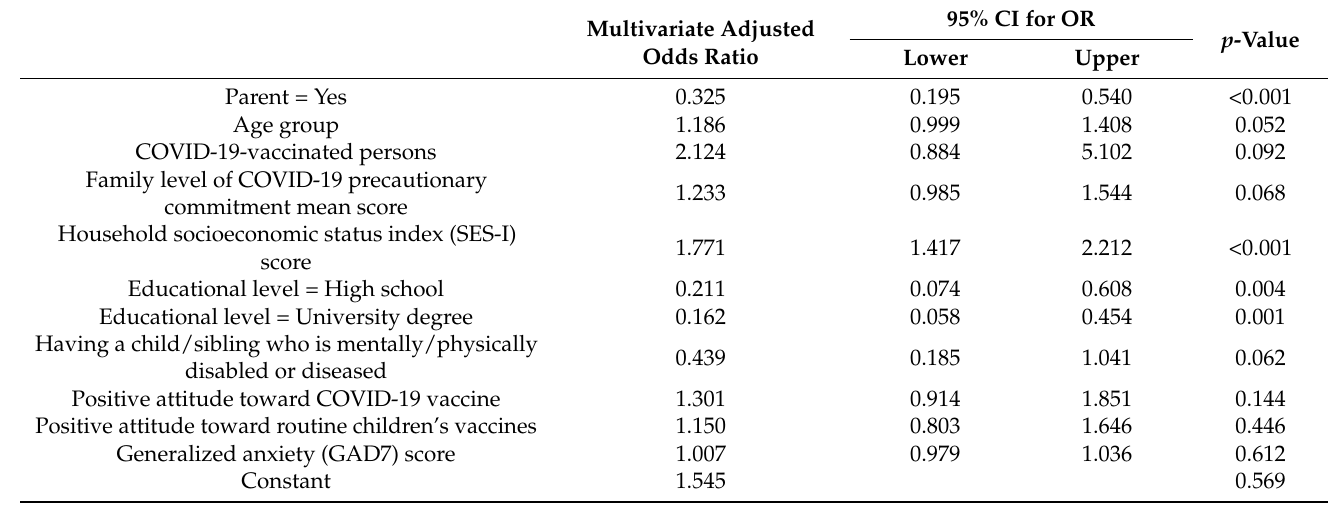
Table 4. Multivariate binary logistic regression of actual uptake of children’s COVID-19 vaccine. 95% CI for OR Multivariate Adjusted p -Value Odds Ratio Lower Upper 0.325 0.195 0.540